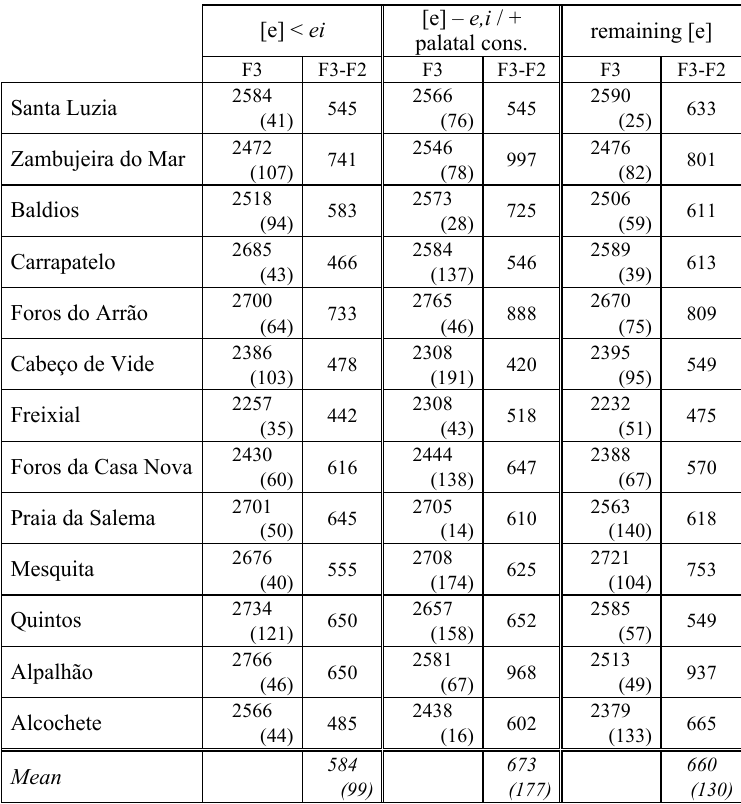
Table VII. F3 (mean values; standard deviations in parentheses) and F3 –